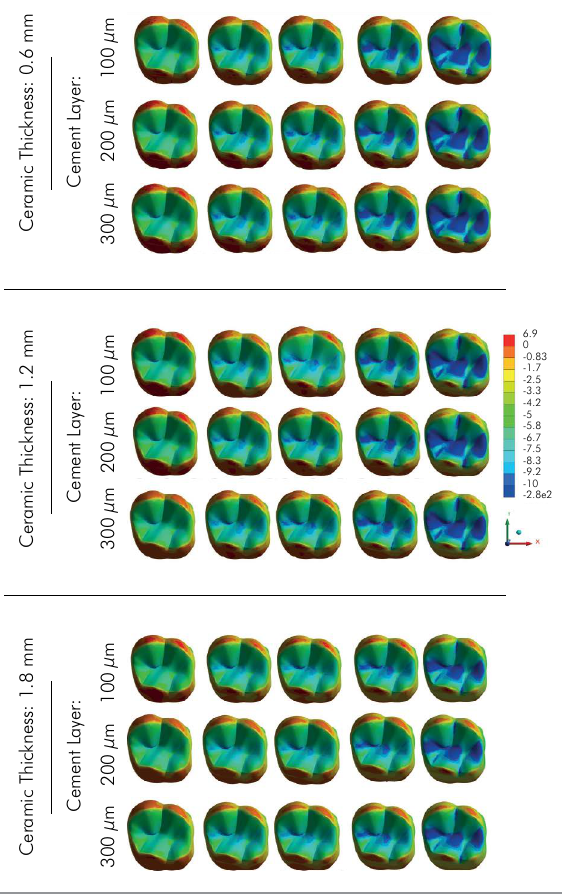
Figure 2. Compressive stress in teeth restored with occlusal veneers in an occlusal